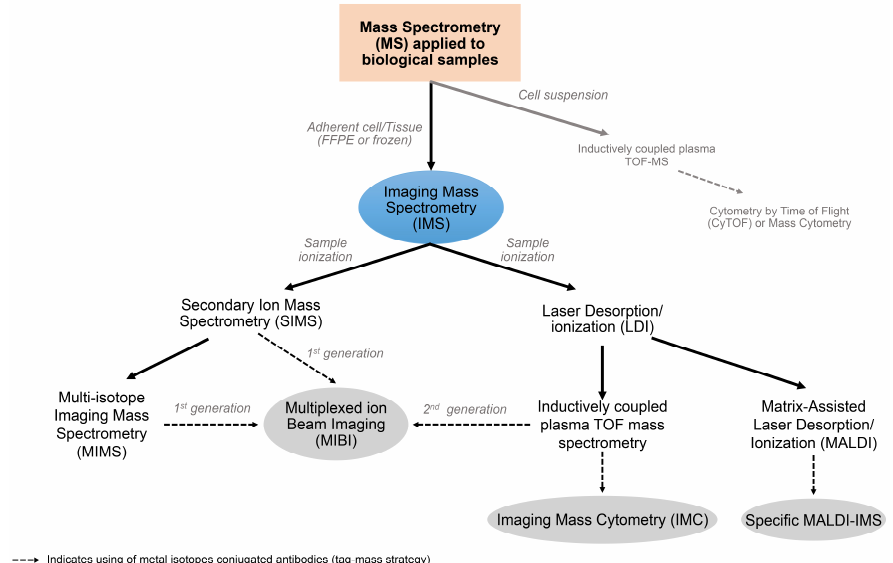
Figure 2. Byproducts and fundamentals of the imaging mass spectrometer. The application of mass spectrometry to biological research began in the last half century and it represents the conjunction of (IMS) came from the idea of building a 2D image with the elemental composition of a biological